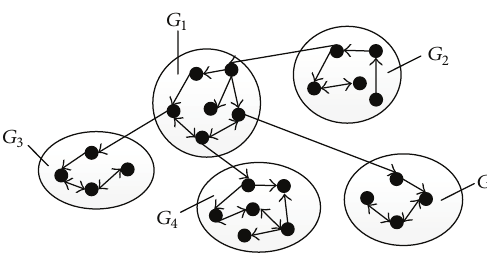
Figure 4: Single input and multiple